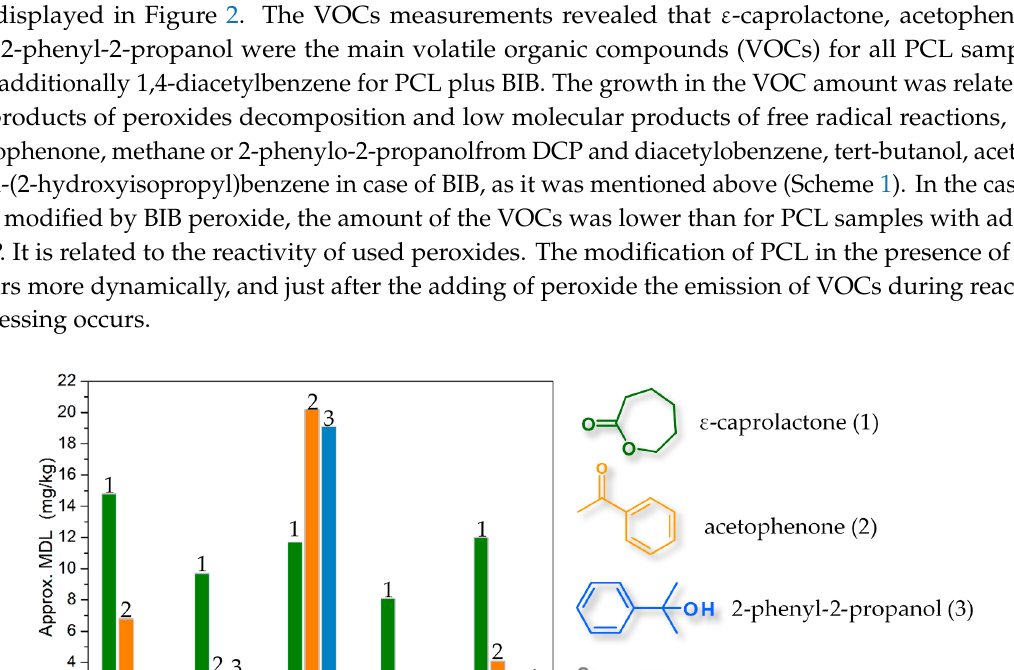
Figure 2. Volatile organic compounds (VOCs) emissions form PCL and PCL modified by the organic peroxides.